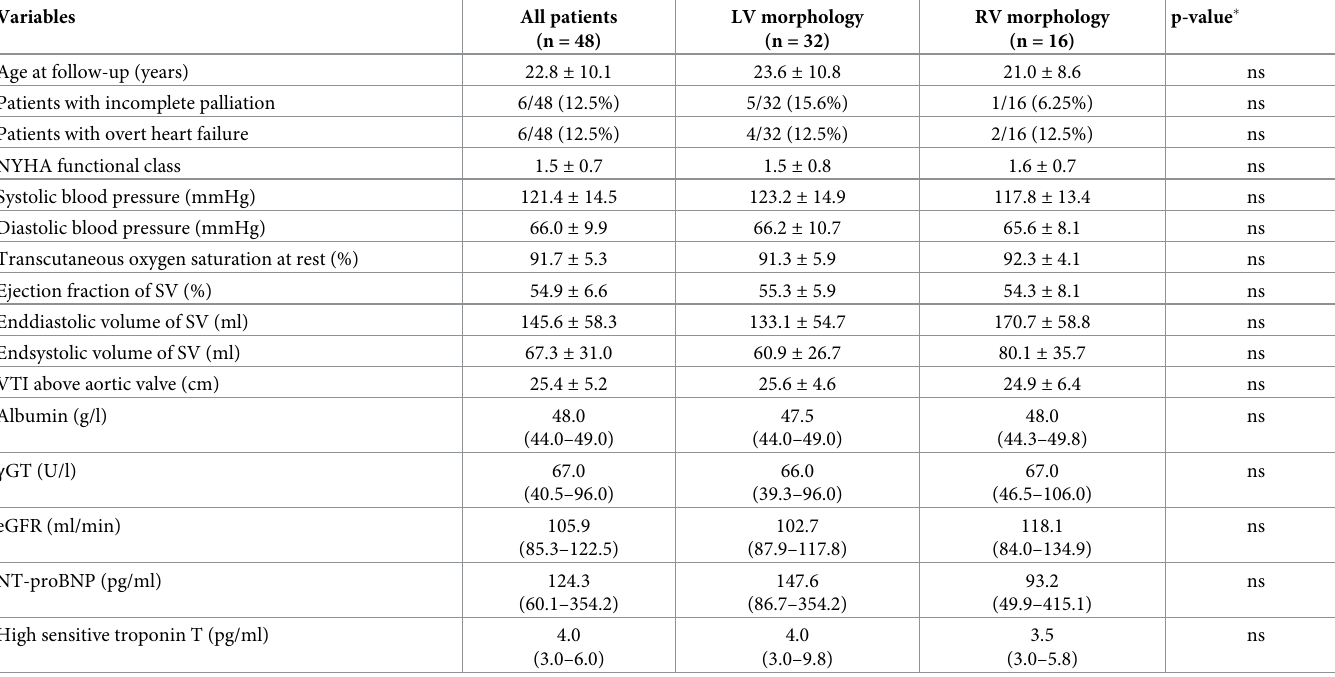
Table 1. Characteristics of UVH patients according to the morphology of the functionally single